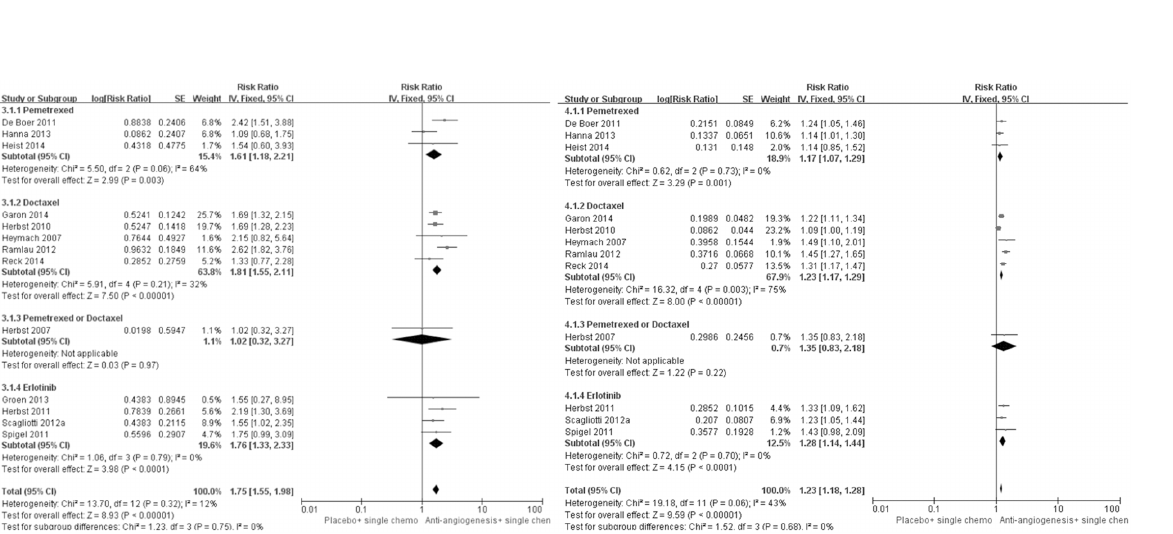
PLOS ONE | DOI:10.1371/journal.pone.0127306 June 2,